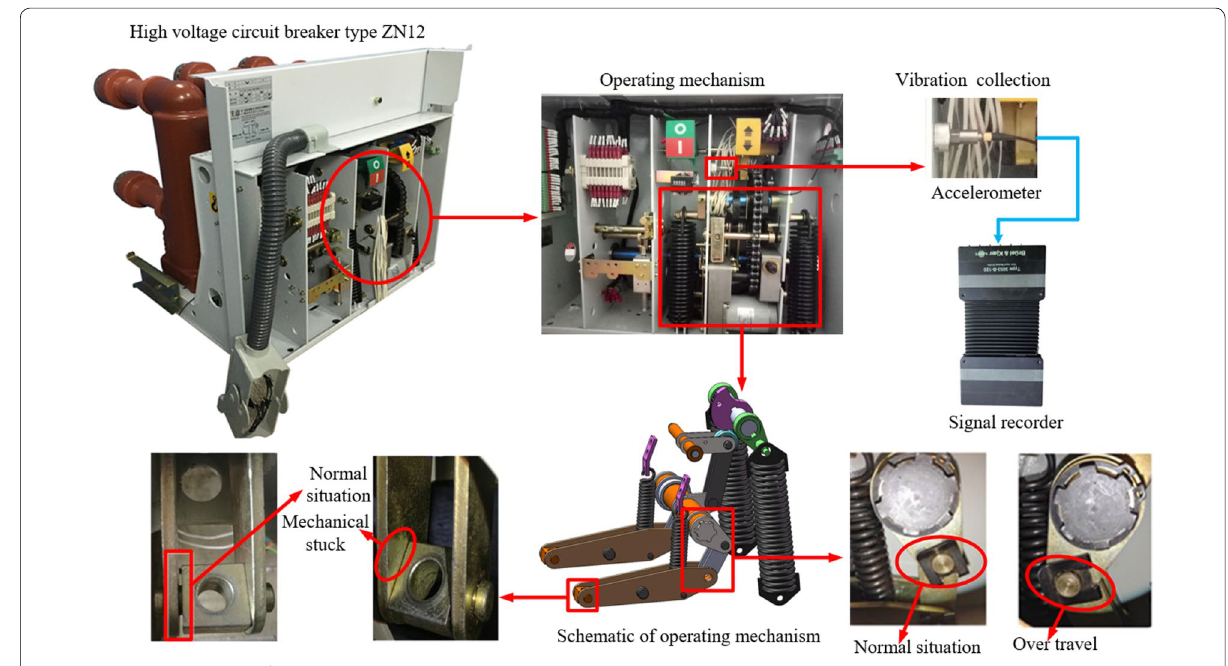
Figure 1 HVCB structure and operation